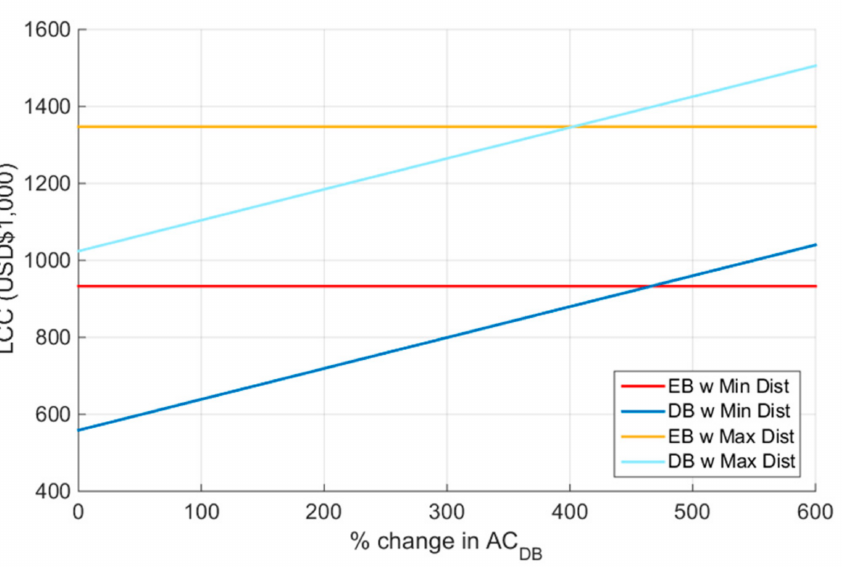
Figure 4. LCCs of the electric and diesel buses, against the percentage change of the AC of diesel